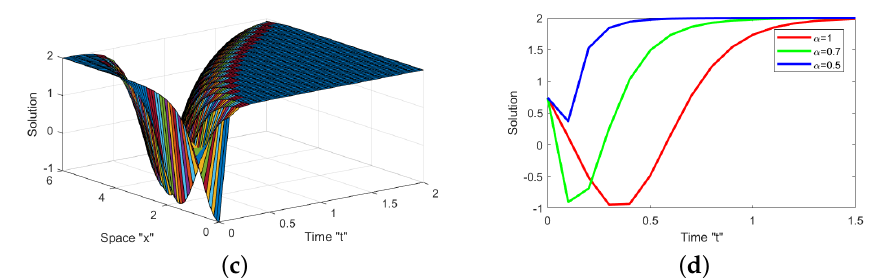
Figure 2. For Equation (26), ( a – c ) with parameters k = 1, ξ 1 = 2, ξ 2 = ξ 3 = 1, ξ 4 = − 1, λ = − 3.75, x ∈ [ 0,6 ] , t ∈ [ 0,2 ] , y = z = 0.5, ω = 1 displays the 3D representations and ( d ) displays the 2D plot for various values of α at t = 2; there is no overlap between the curves of the solution.